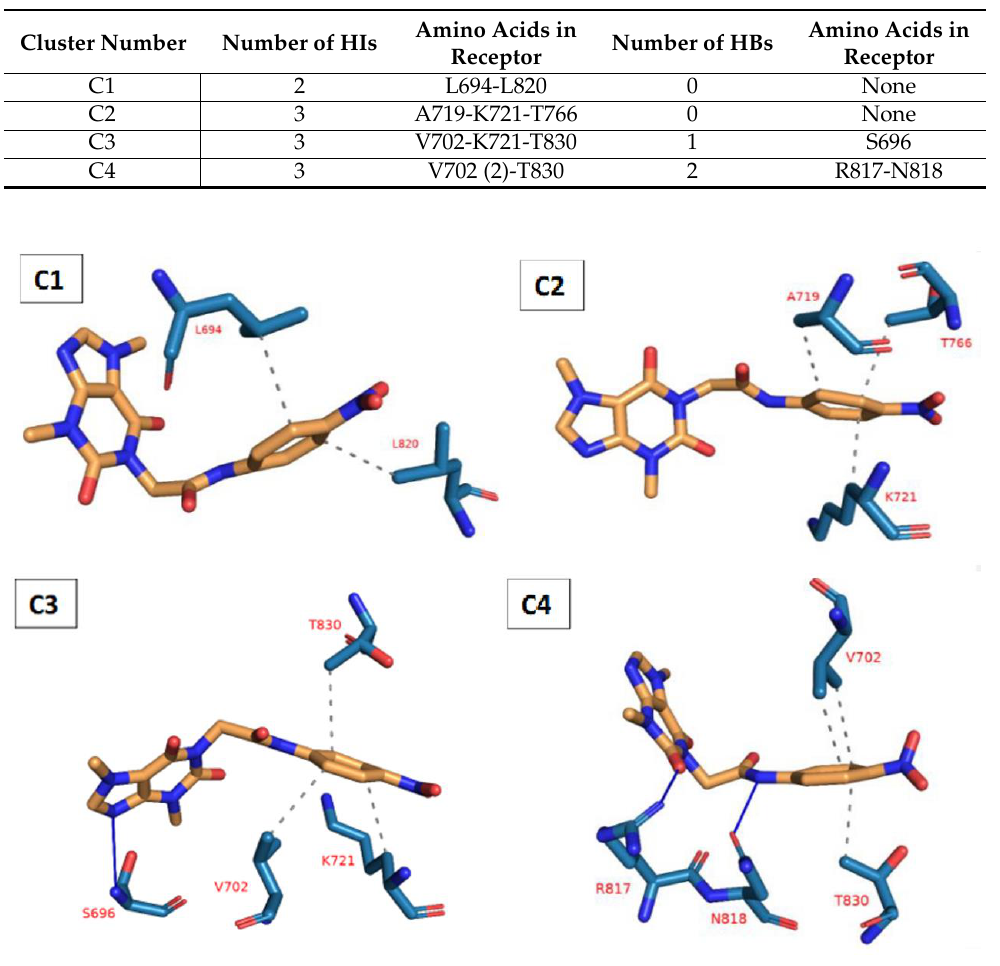
Figure 10. Interactions obtained from the PLIP of every cluster. HB: blue solid line, HI: dashed gray line, amino acids: blue sticks representation, and T-2-PNPA : orange sticks representation.